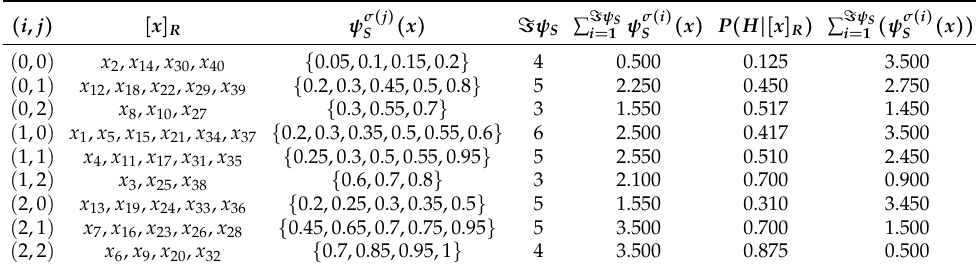
Table 3. Statistical results of house classes under R and the related calculation